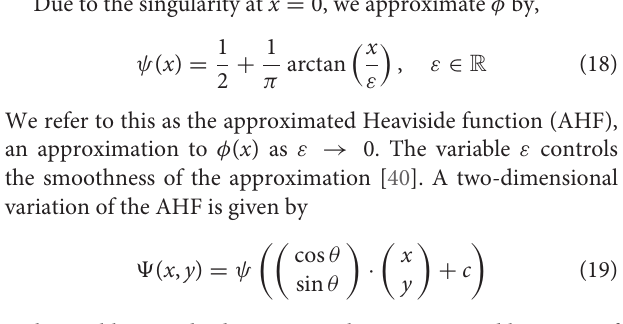
Due to the singularity at x = 0, we approximate φ